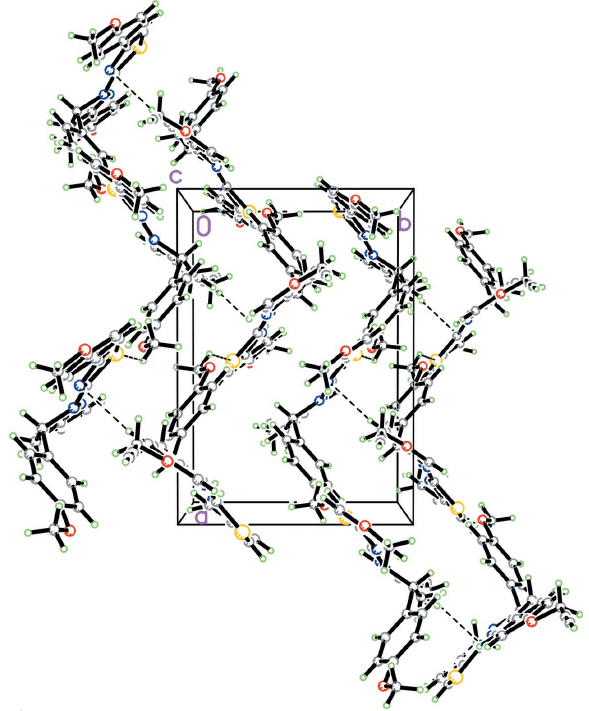
Figure 2 Packing diagram for 3 viewed along the c axis. C—H (cid:2)(cid:2)(cid:2) N intermolecular interactions are shown as dashed lines.